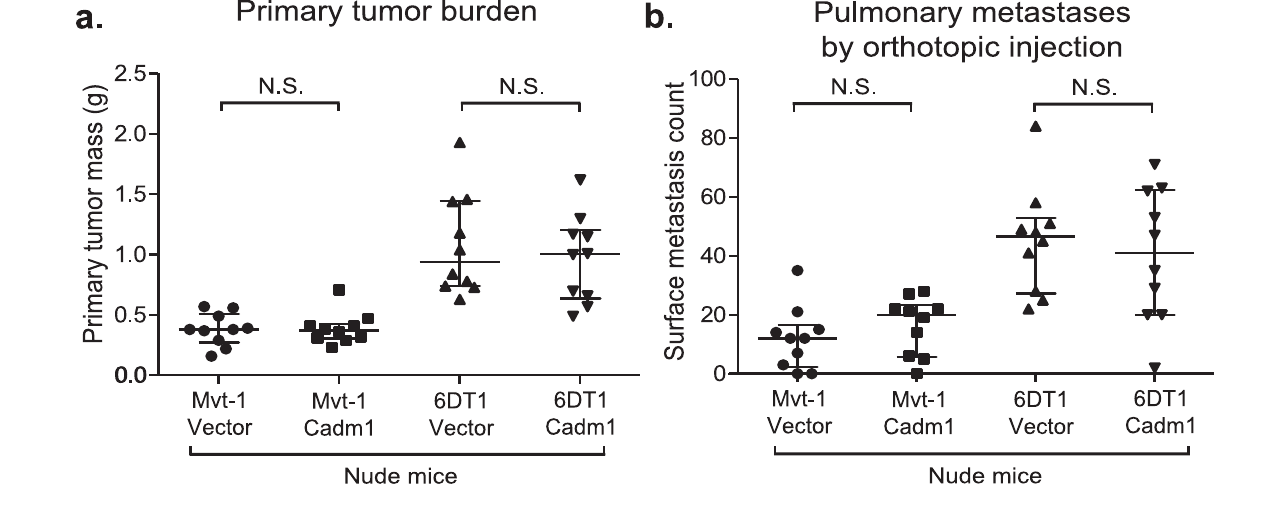
Figure 4. Pulmonary metastases of Mvt-1/ Cadm1 cells express attenuated levels of Cadm1 . Matched primary tumor and lung sections were immunohistochemically (IHC) stained with antibody against the V5 epitope. Immunohistochemical staining of the primary tumors produced by control (a) and Cadm1 -V5 (b) expressing cells. IHC stained lung sections of mice implanted with control (c) and Cadm1 -V5 (d). Hematoxylin and eosin (H&E) stained lung sections of mice implanted with control (e) and Cadm1 -V5 (f) expressing cells. Insets show 20 6 magnification of boxed area (L.N., lymph node; black bar indicates 1 um). Level of (g) exogenous and (h) total Cadm1 mRNA from grossly dissected pulmonary metastatic nodules of mice injected with Mvt-1/Vector versus Mvt-1/ Cadm1 relative to the original cell lines prior to injection.